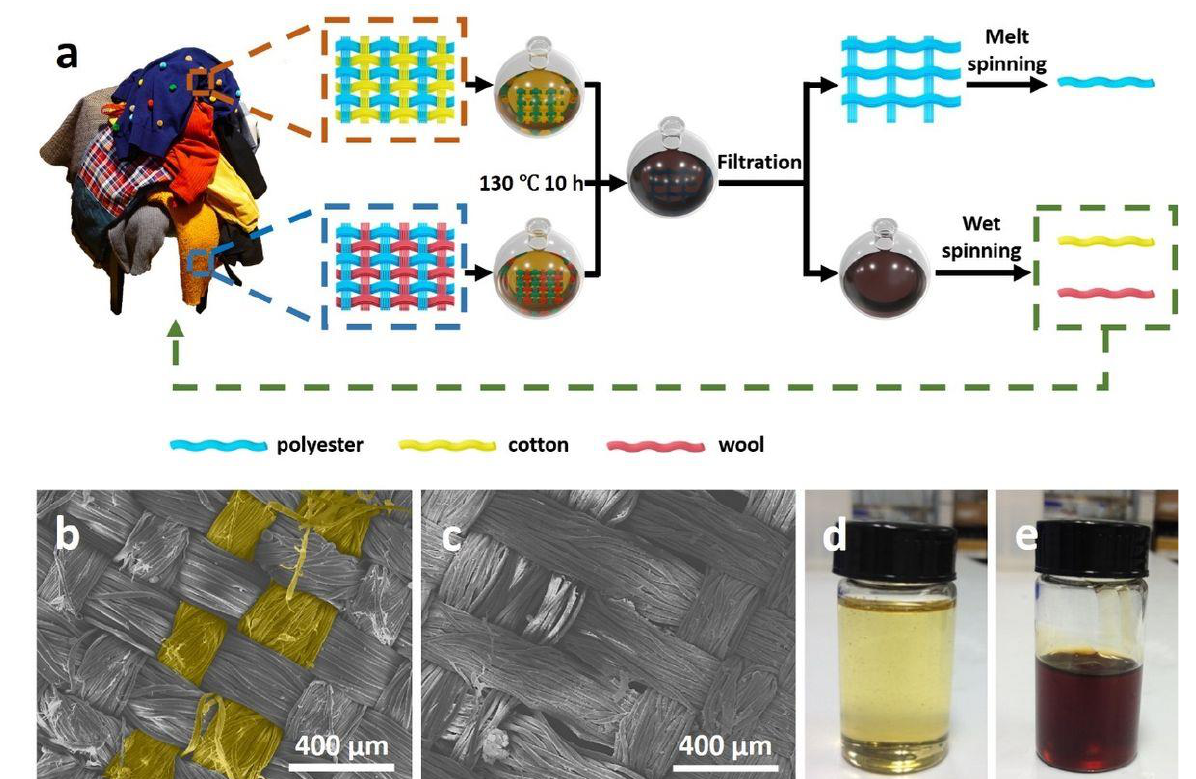
Figure 10. Regeneration of textile waste fibers via ILs to separate cotton cellulose from polyester composite blended fabrics: A schematic diagram of the separation and regeneration of cotton–polyester blended fabric ( a ). SEM image of cotton–polyester blended fabric before dissolution ( b ). SEM image of the polyester fabric remaining after dissolution ( c ). Photograph of the [BMIM]Cl ( d ). Photograph of cellulose and wool keratin dissolved in [BMIM]Cl ( e ) (reprinted with permission from [106]).